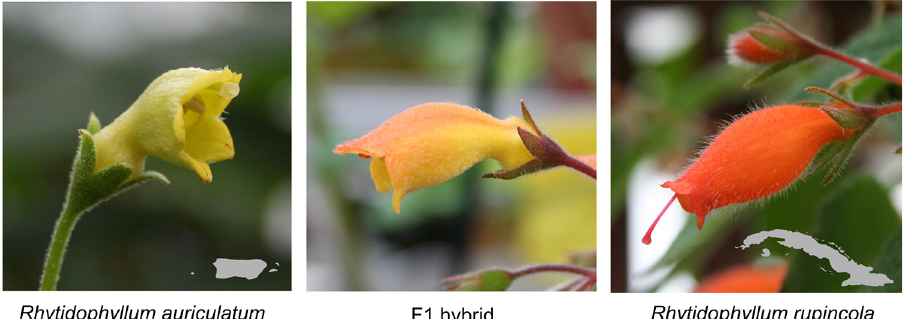
Fig 1. The two parental species studied. The small maps at the bottom-right corner of the images indicate their geographic origin. Photo credits: S.